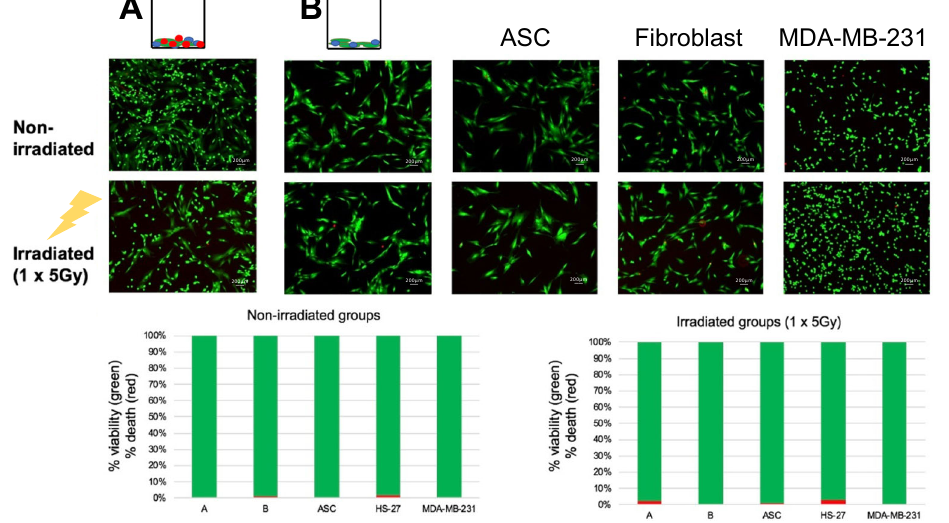
Figure 1. Analysis of radiation on cell viability. Top: Fluorescent micrographs of cells (group A and B) in non-irradiated and irradiated groups, separated per cell co-culture and cell monocultures. Below, proportional bar graphs showing quantified live/dead cells from irradiation. TNBC co-culture (Group A) and fibroblasts alone showed cell viability of approximately 97% in irradiated groups.